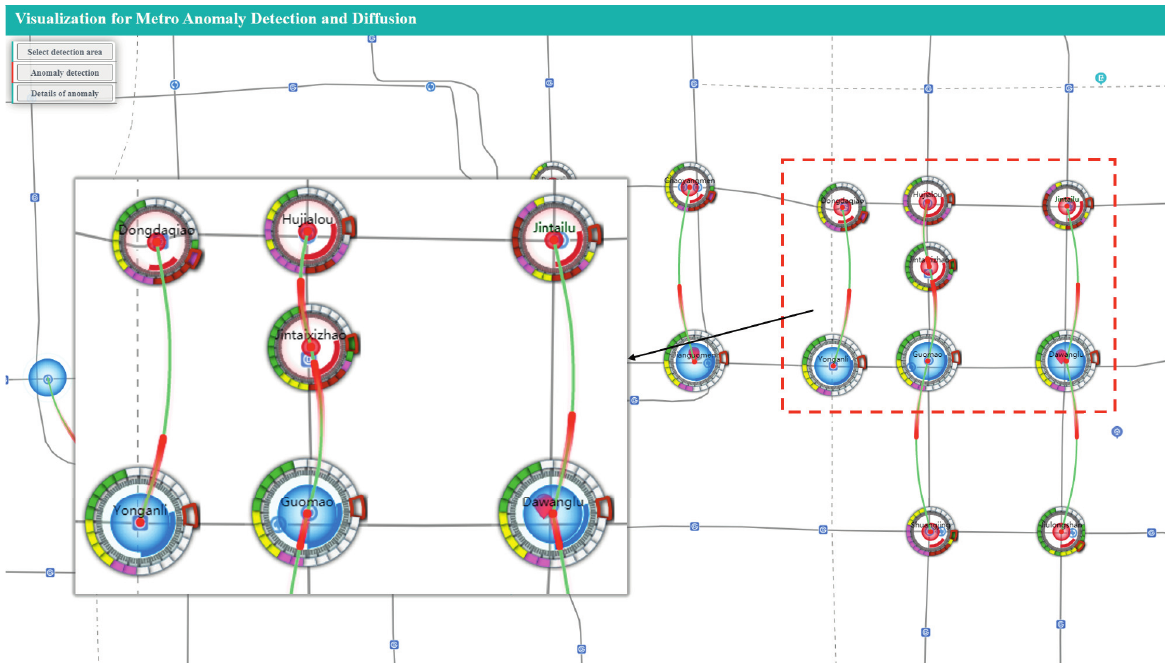
Figure 12: Anomalies of Line 1 caused anomalous diffusion of passenger flow at 5:00 on August 23,